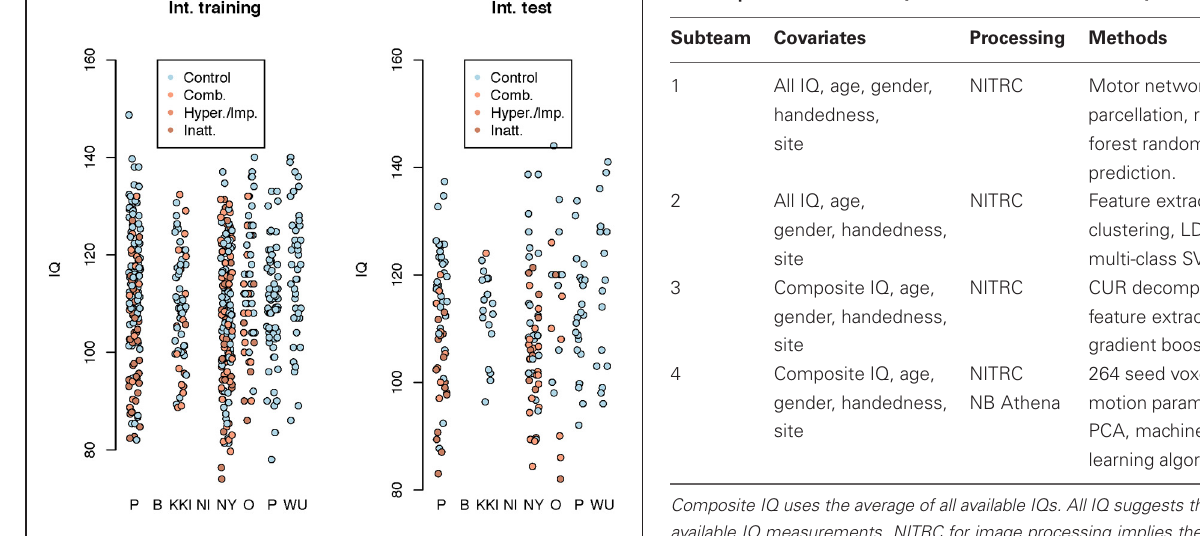
Table 1 | Overview of final prediction methods used by each